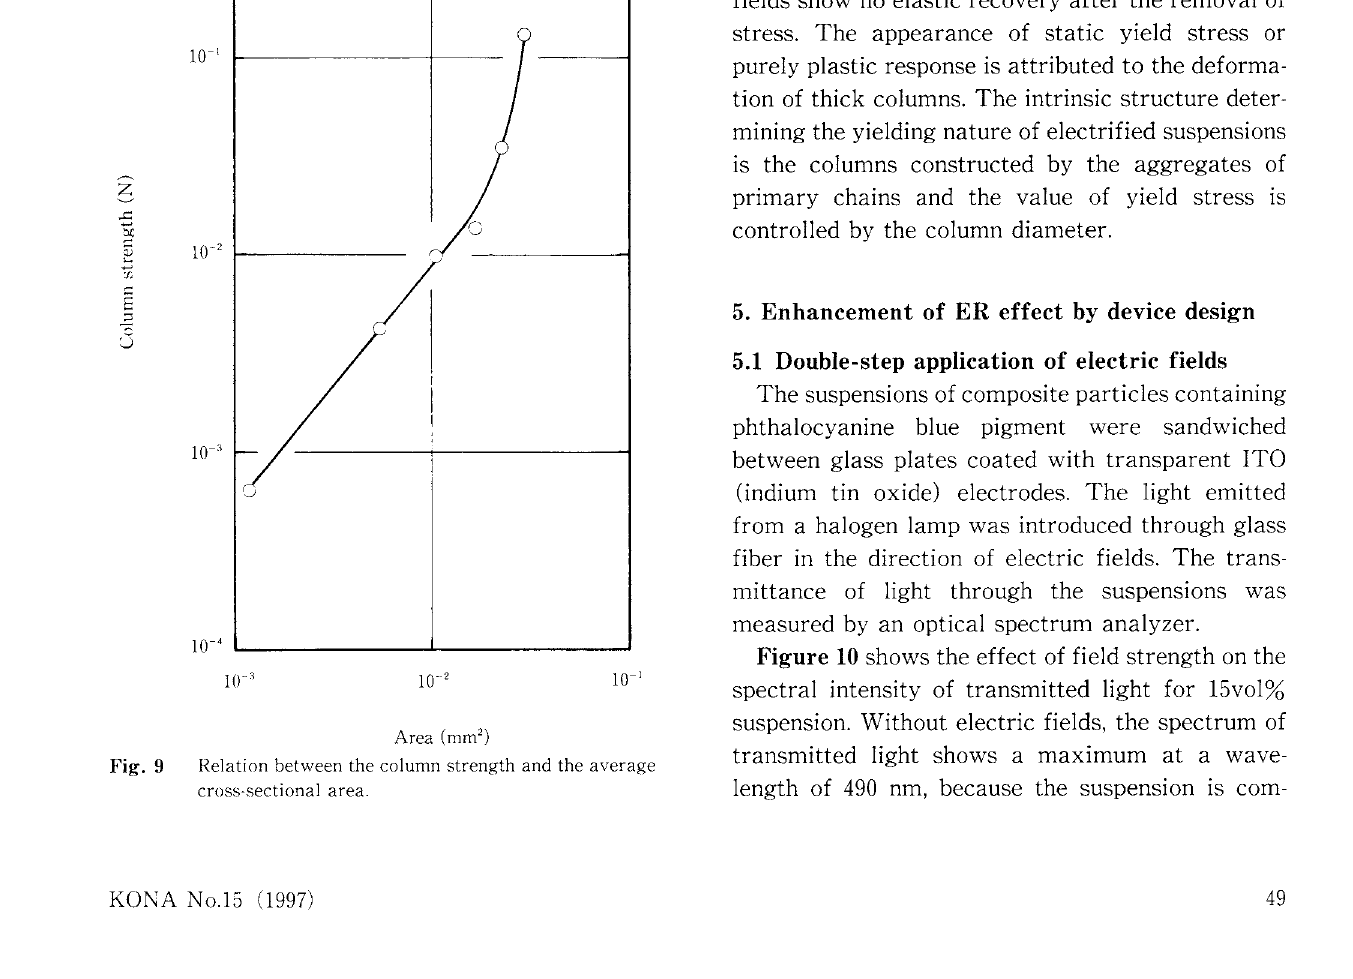
Relation between the column strength and the average cross-sectional